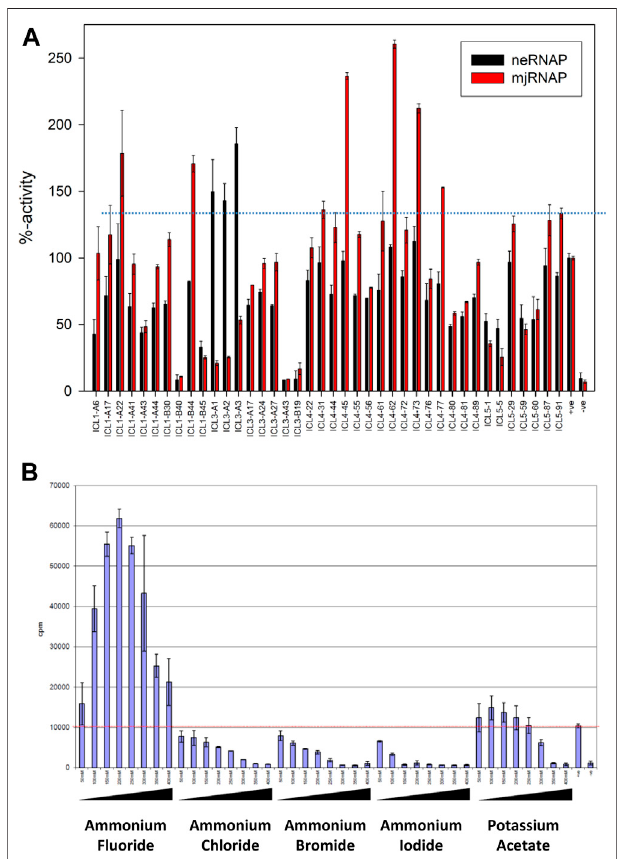
FIGURE 5 | Effect of different assay buffer compositions on the catalytic activities of ne RNAP and mj RNAP (A) The transcriptional activity under “ standardconditions ” isde fi nedas100%.Theactivitiesof ne RNAPinthissetof buffersisshowninblack,andtheperformanceof mj RNAPunderthesame conditions is shown in red (B) Fluoride-speci fi c effect among halogen salts. The catalytic activity of ne RNAP at various salt concentrations ((50 – 400 mM) is shown,includingammonium fl uoride,ammoniumchloride,ammoniumbromide, ammonium iodide and potassium acetate. Fluoride has the most distinct effect.